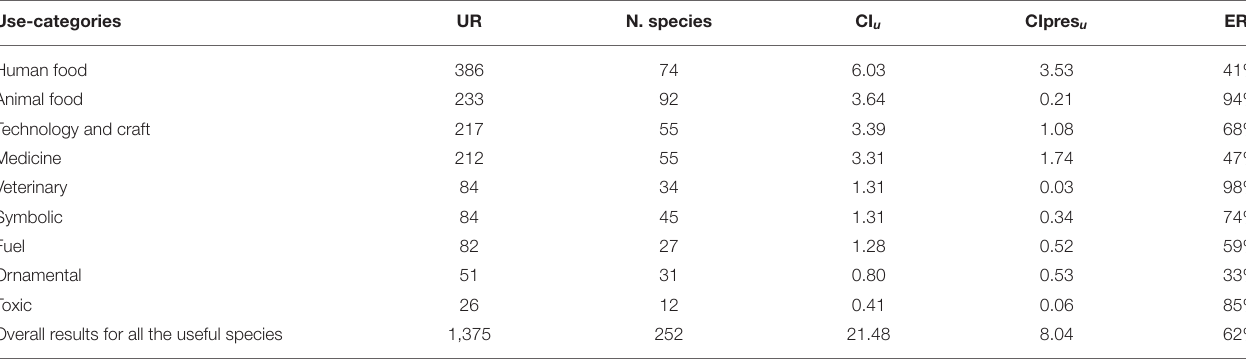
TABLE 1 | Summary of the results of the interviews ( N = 64) about all the use-categories: number of use-reports, number of species, total and present cultural importance index, and erosion rate. Use-categories UR Human food Animal food